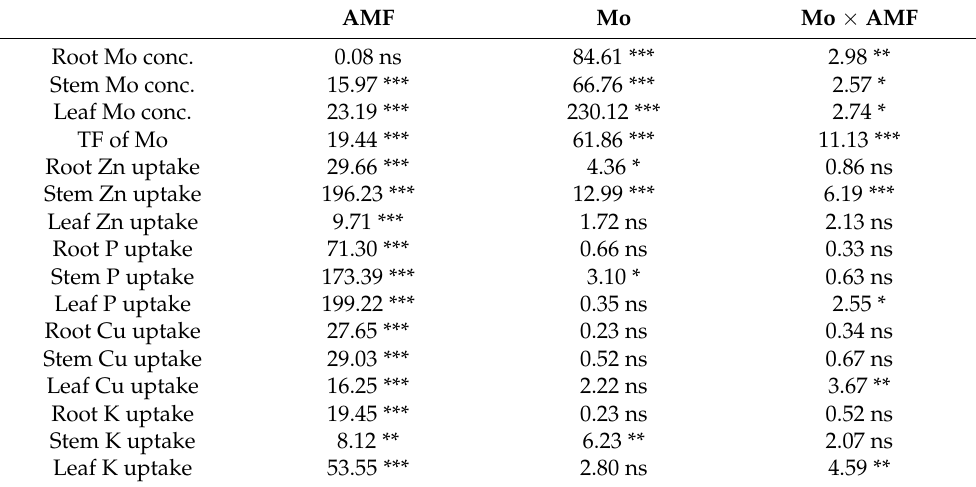
Table 2. Significance levels ( F values) of AMF inoculation and Mo addition, and their interactions on measured variables by a two-way analysis of variance. AMF Mo Mo × AMF Root Mo conc. Stem Mo conc. Leaf Mo conc. Root Zn uptake Stem Zn